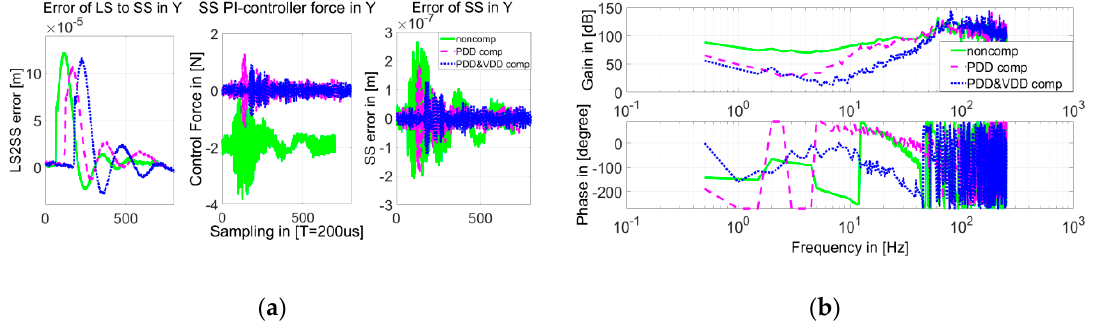
Figure 16. ( a ) Time response and ( b ) frequency response with impact excitation on the Long-Stroke (LS) actuator stage.